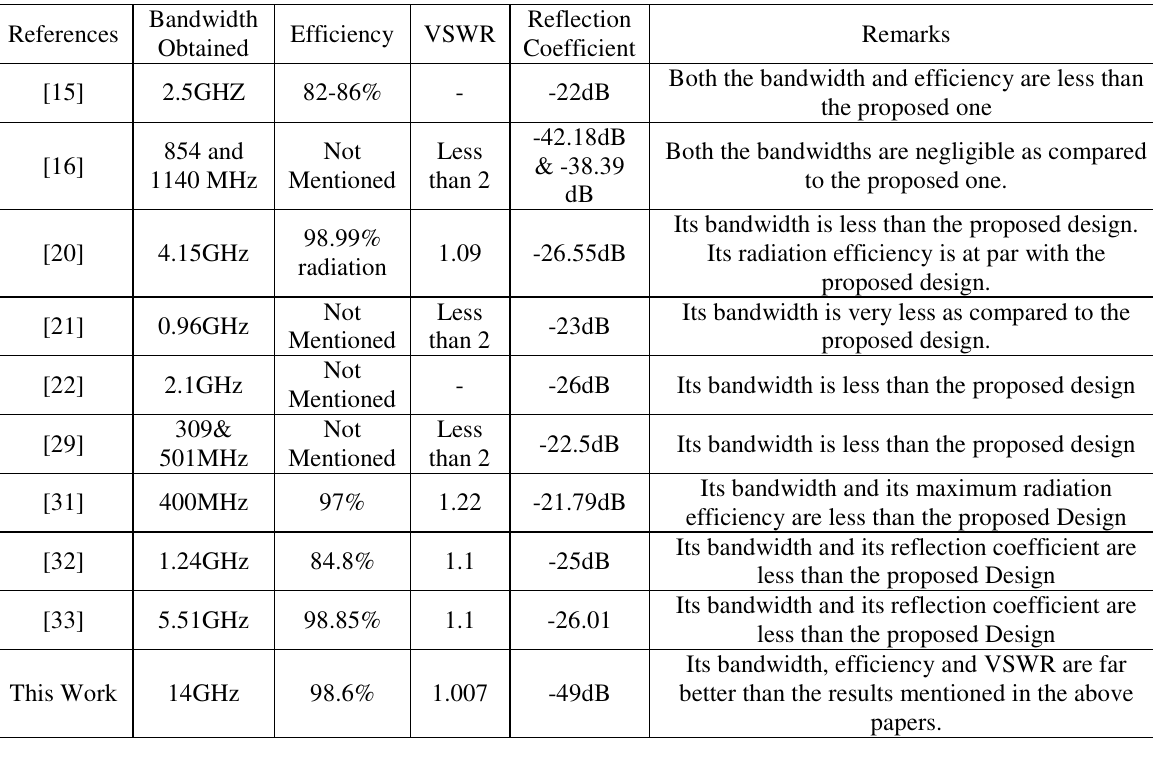
TABLE 3: COMPARISON OF EXISTING ANTENNA MODELS WITH THE PROPOSED